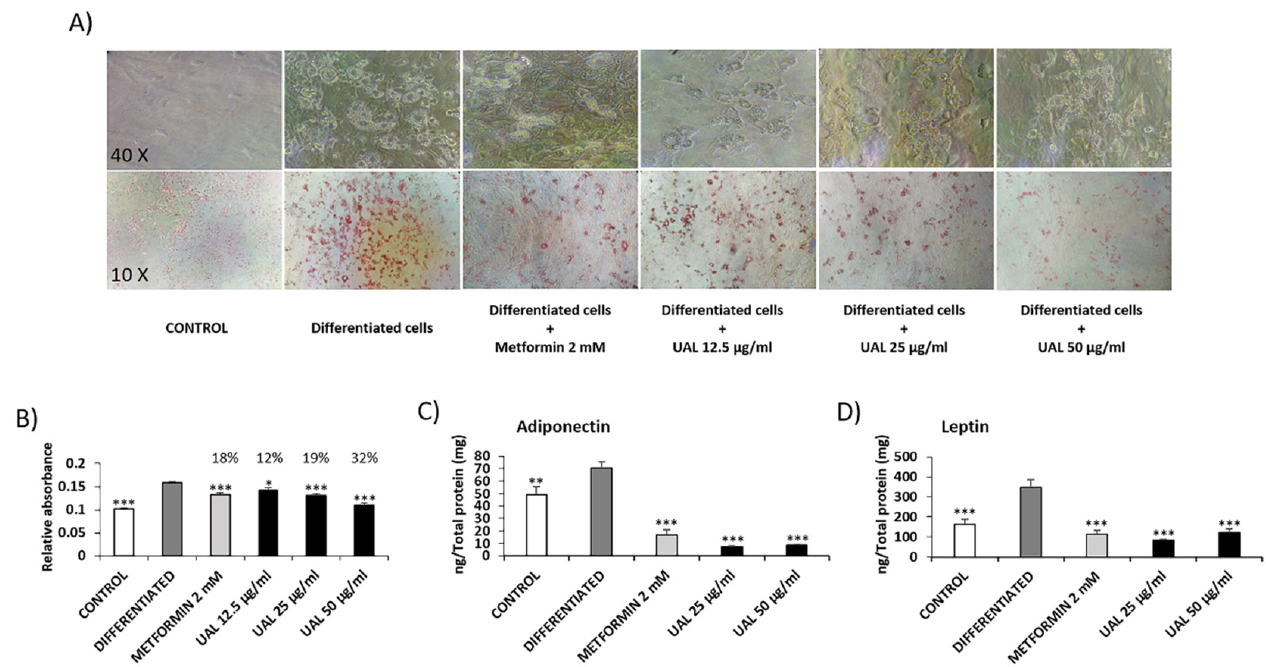
Figure 5. Effect of UAL on lipid accumulation in 3T3-L1 and protein expression in 3T3-L1 adipocytes. 3T3-L1 cells were differentiated and treated with UAL for 7 days. Metformin was used as positive control. ( A ) Photographs of 3T3-L1 adipocytes before and after Oil Red O staining. ( B ) 3T3L-1 cells were stained with oil red and lipid accumulation was quantified. Values are expressed as mean ± SEM of four independent experiments each one performed in triplicate. ( C ) Amount of adiponectin, and ( D ) amount of leptin present in the supernatant of the cells after 7 days of treatment. Values are expressed as mean ± SEM of three independent experiments each one performed in duplicate. * p < 0.05, ** p < 0.01, *** p < 0.001 vs. DIFFERENTIATED (ANOVA with Dunnett ´ s post hoc test).